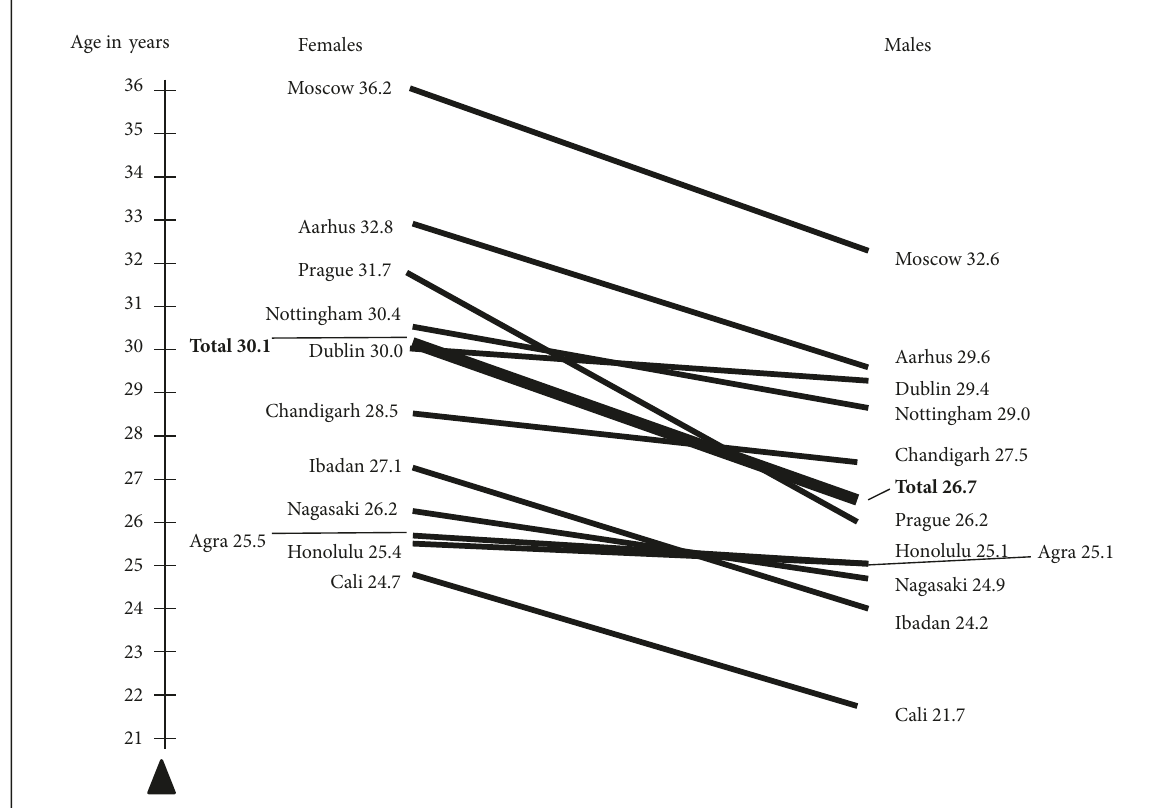
Figure 3: WHO Determinants of Outcome Study: mean ages at onset in the centres and the total sample (N=1,292). Source: [12].